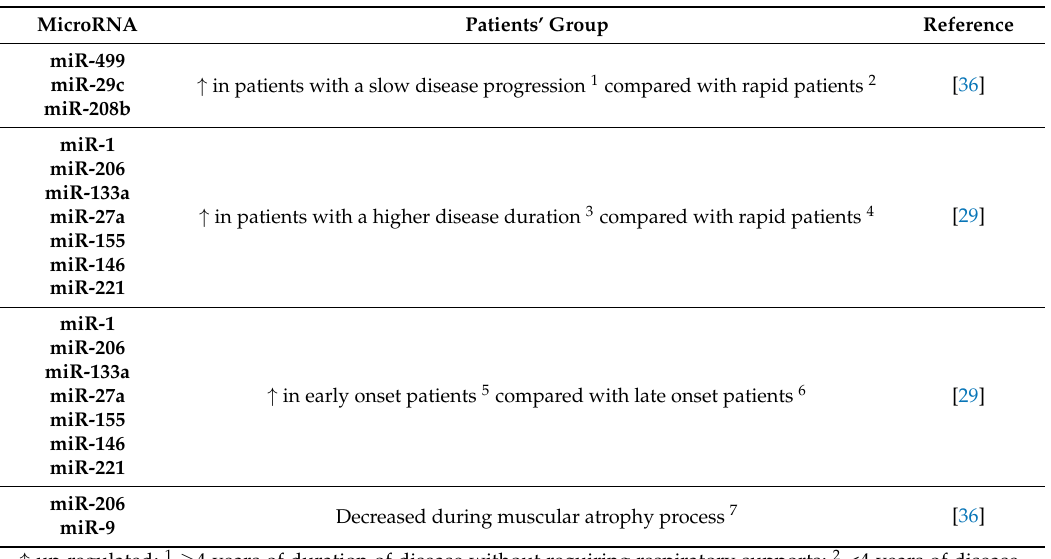
Table 3. Dysregulated microRNAs in stratified ALS